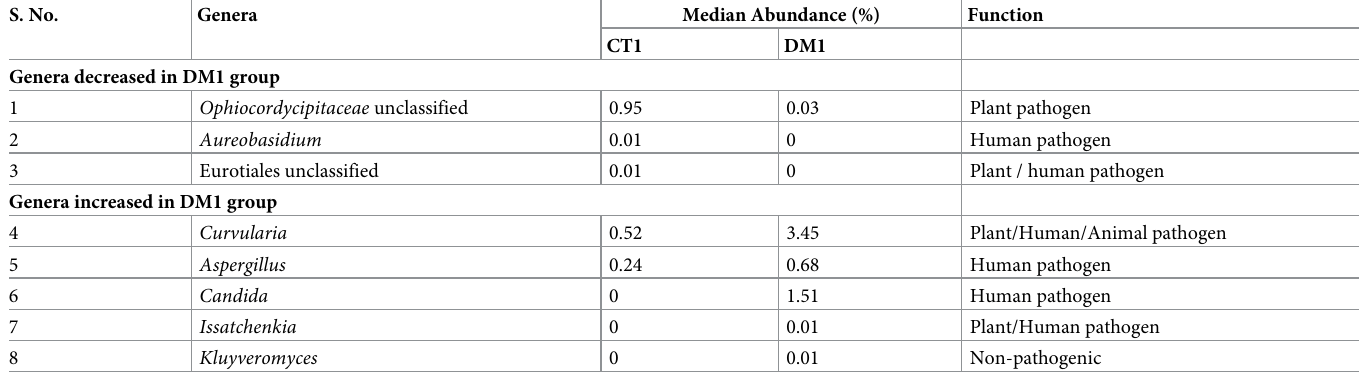
Table 3. Significant differences in the median abundance of discriminatory genera ( > 0.01% in any one of the groups; P-value � 0.05) in the gut mycobiomes from control (CT1, n = 6) and diabetic (DM1, n = 6) rats. S. No.